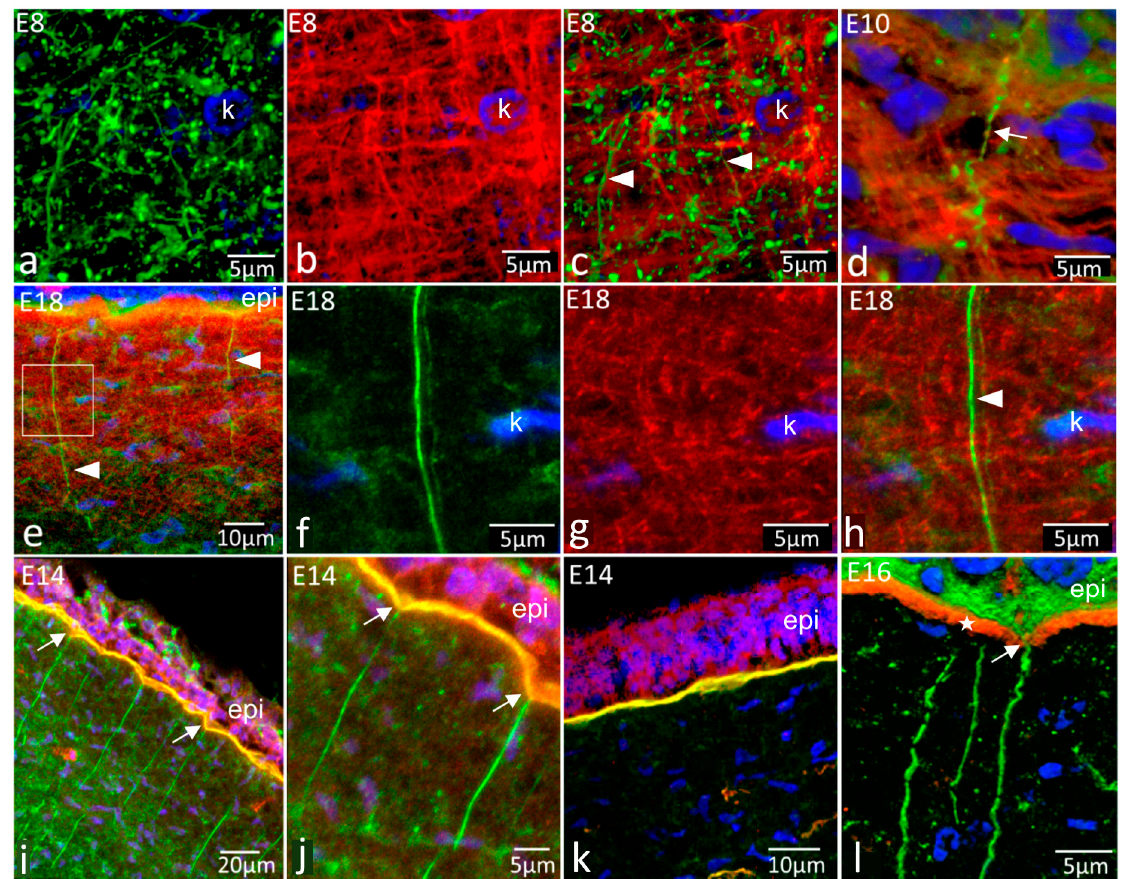
Figure 3. Immunohistochemistry for fibronectin (green) and tenascin-C (red) to show possible interactions and relationships with the epithelial basement membrane. K, keratocyte nuclei; epi, epithelium. ( a – c ) Dual labelling for fibronectin and tenascin-C, individual images (( a , b ), respectively) and dual label overlay ( c ) of E8 cornea. Although present in the same regions of stroma, there is no clear codistribution—both have distinctive organisations, with fibronectin often in the spaces enclosed by tenascin-C fibrillar mesh; ( d ) Dual label for fibronectin and tenascin-C at E10. Fibronectin strings (arrow) pass into the tenascin-C-rich highly ordered matrix but show no structural similarity with it; ( e ) Fibronectin and tenascin-C at E18. Low magnification shows extensive tenascin-C labelling in the anterior cornea, with fibronectin strings (arrowheads) passing through it; ( f – h ) Dual-label images for fibronectin and tenascin-C. Individual images (( f , g ), respectively) and dual label overlay ( h ) of E18 cornea at high magnification. No direct structural correspondence in the organisation of the two glycoproteins is evident. The fibronectin strings (arrowhead) pass through the highly organised tenascin-C network, which shows no structural disturbance associated with the fibronectin strings; ( i , j ) Dual label for fibronectin and type IV collagen (red) in E14 cornea, low and high magnification, respectively. Yellow/orange label indicates colocalisation in the epithelial basement membrane. The fibronectin strings do not contain any type IV collagen and have an abrupt boundary at their interface with it, at the base of the conical depressions (arrows); ( k ) Dual label for type IV collagen (green) and perlecan (red) in the E18 cornea. Perlecan colocalises with type IV collagen (yellow/orange signal) but does not extend from the basement membrane into the corneal stroma, so it is not a component of the fibronectin strings; ( l ) Dual label for fibronectin and tenascin-C in E16 anterior cornea. A fibronectin string is observed passing through a pore (arrow) in the tenascin-C-rich Bowman’s layer (asterisk) as it passes from the basement membrane into the stroma.